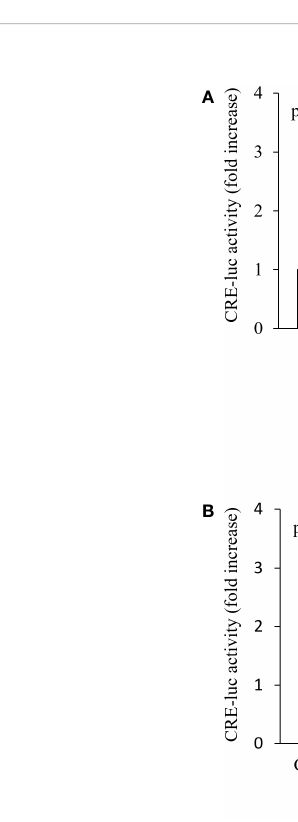
FIGURE 2 Effects of GnIH and NPFF peptides on CRE-luc activity in COS-7 cells transfected with sea bass GnIHR. Cells were challenged with GnIH and NPFF peptides alone (A) or co-treated with FSK (10 m M) and each peptide (1 m M, B ) for 6 h and then harvested for assays. Data are presented as the mean ± SEM (n=6). Different letters indicate statistically signi fi cant differences between mean values (ANOVA one-way p <